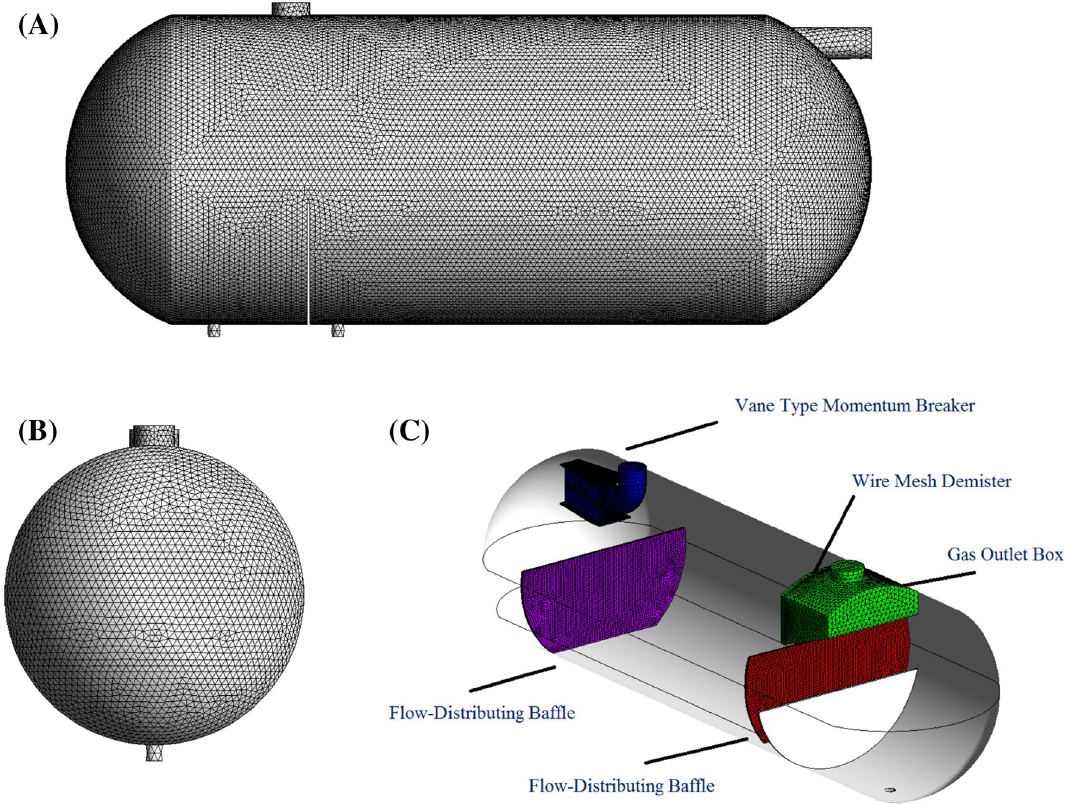
Fig. 2 Generated meshes for Case 3 ( a ) Case 7 ( b ) and internals of Case 7 ( c